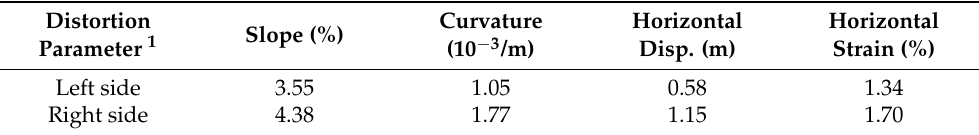
1 (sign of the data is not distinguished).